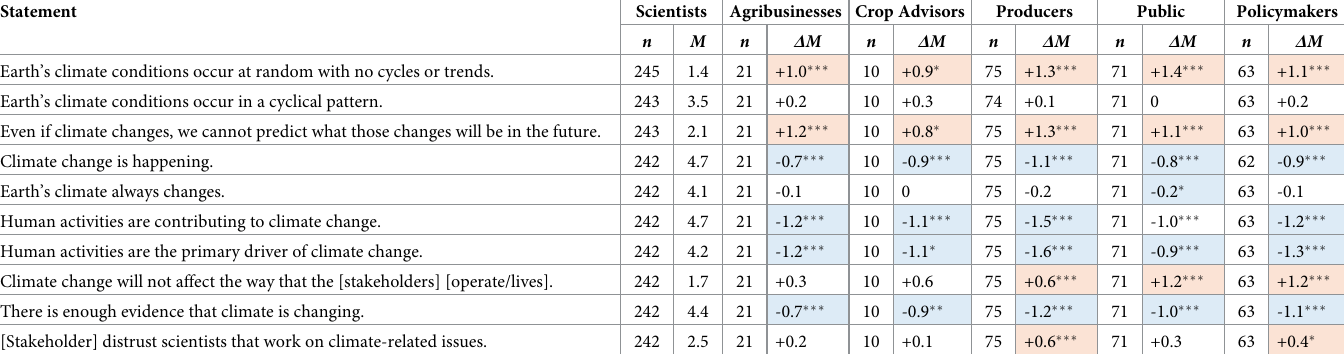
Table 1. Scientists’ agreement to statements compared to scientists’ perspective on how stakeholders would respond to the same statements regarding climate